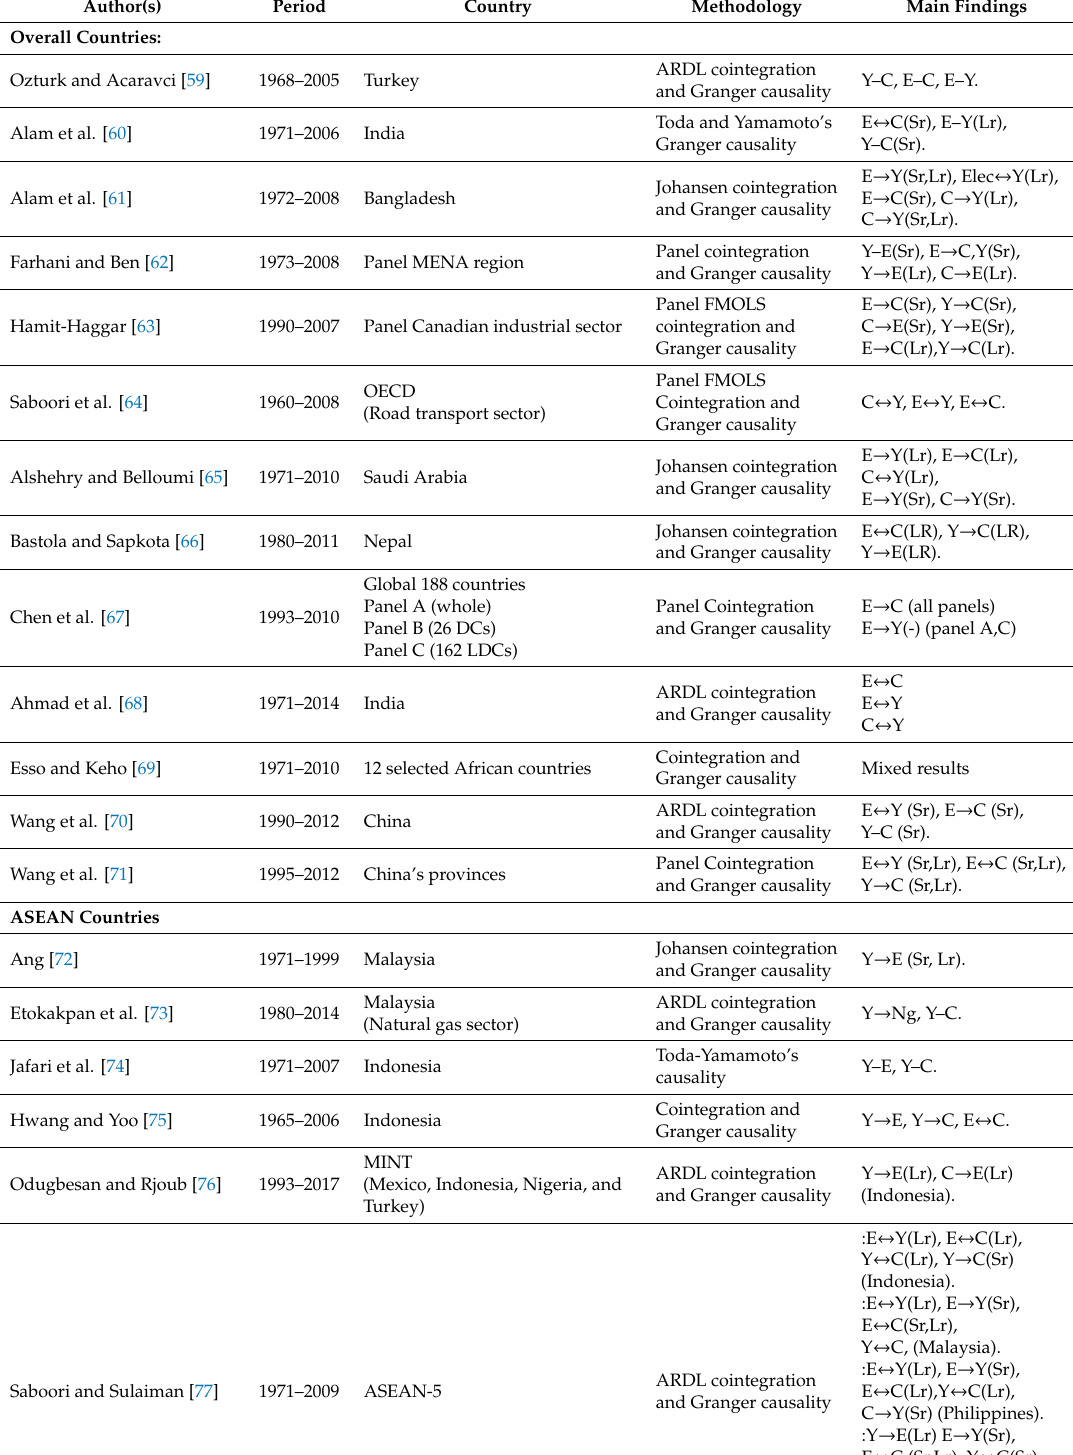
Table A2. Literature on “Energy–Growth–CO 2 ” causality